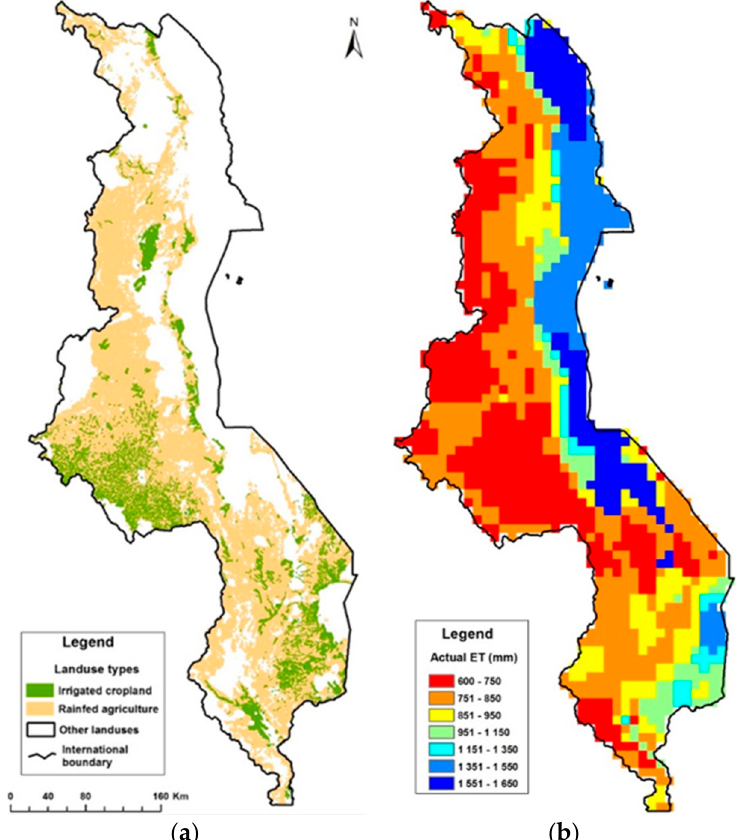
Figure 2. ( a ) Malawi’s irrigated and rainfed agricultural land areas; and ( b ) long term actual evapotranspiration (ET a ).